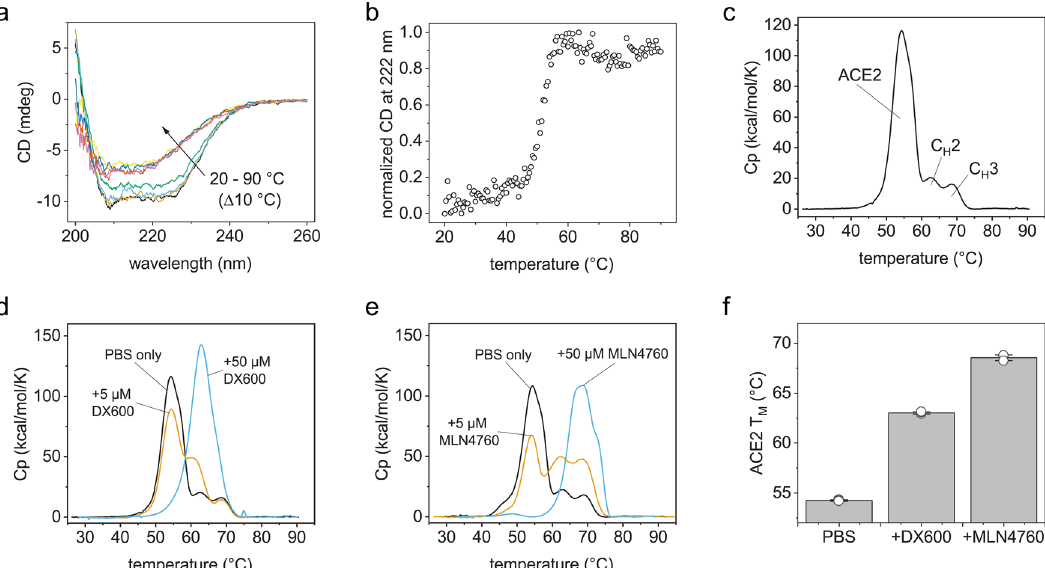
Fig. 2 Thermal stability of ACE2-IgG4-Fc. a FUV CD spectra obtained at different temperatures. b Change in the CD signal at 222 nm during heating. DSC thermograms of ACE2-IgG4-Fc ( c ) without inhibitors or in the presence of ( d ) DX600 or ( e ) MLN4760. The concentration of ACE2-IgG4-Fc was 5 µ M. f Melting temperatures of the ACE2 domain in ACE2-IgG4-Fc (5 µ M) without inhibitor or with 50 µ M inhibitor. The bars are mean values of triplicates. The error bar is the standard deviation. The circles depict the values from each